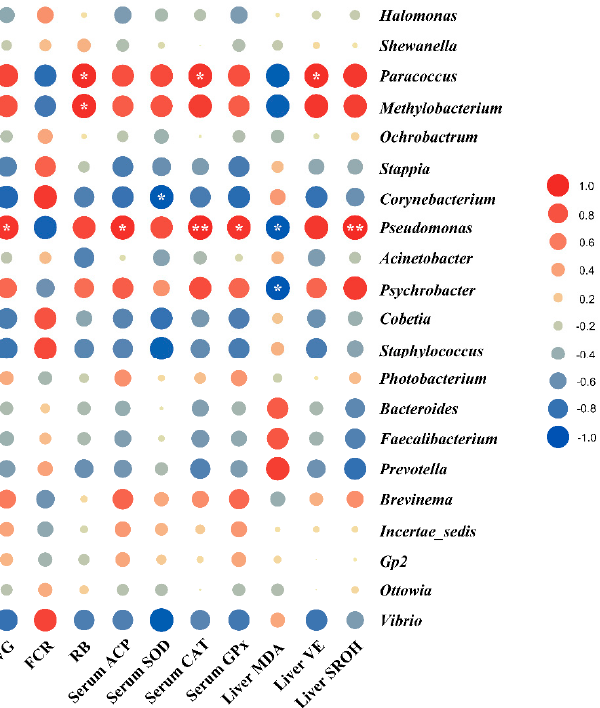
Figure 7. The Pearson correlation between gut microbiota and host responses. Circles in the balloon plot denoting the direction of the association are colored red (positive) or blue (negative) and are overlaid with the white symbol “*” indicating a significant correlation. Values marked with a white symbol “*” are significant correlations ( p < 0.05), and “**” are very significant correlations ( p < 0.01). WG: weight gain rate; FCR: feed conversion ratio; RB: respiratory burst activity; ACP: alternative complement pathway; SOD: copper-zinc superoxide dismutase; CAT: catalase; GPx: glutathione pe- roxidase; MDA: malondialdehyde; VE: Vitamin E; SROH: scavenging rate of hydroxyl radical. 4. Discussion 4.1. Growth Performance and Body Composition Fish fed the soymeal-based diets with or without functional additives, i.e., the SBM and FAS groups, suppressed the growth performance in the present study, indicating that Japanese seabass cannot tolerate conventional dietary soybean meal as a fish meal substi- tute at 50%. Overall, previous studies concluded that the optimal replacement level of fishmeal with conventional soybean meal is highly variable for carnivorous fish species. For example, similar to our findings, the optimal replacement level should be less than 50% in some carnivorous fish species, including, but not limited to, Atlantic salmon, Salmo salar (30%) [33], Chinese sucker, Myxocyprinus asiaticus (30%) [34], European sea bass, Di- centrarchus labrax (25%) [35], Japanese flounder, Paralichthys olivaceus (24%) [36], spotted